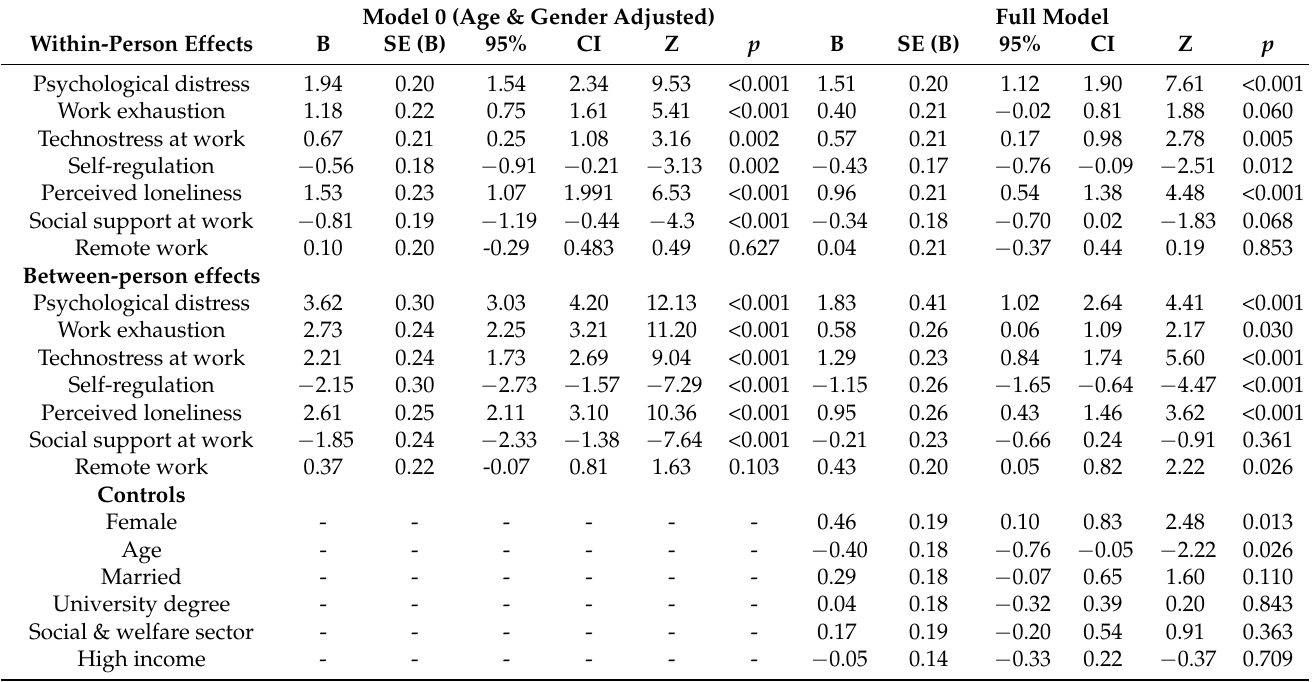
Table 3. Hybrid models showing within-person and between-person effects on COVID-19